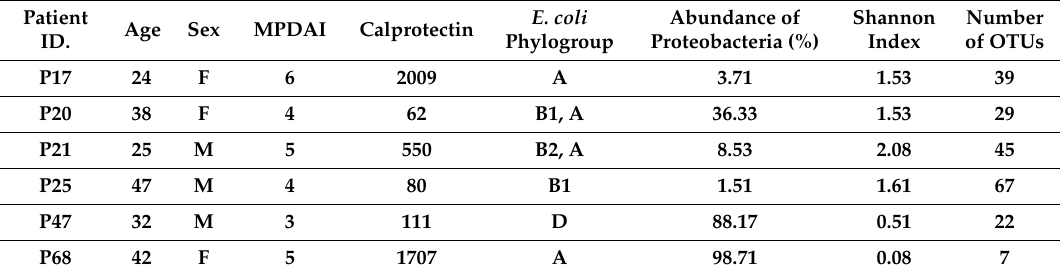
Table 1. Patient characteristics, modified pouchitis disease activity index (mPDAI), calprotectin, E. coli phylogroup, relative sequence abundance of Proteobacteria, Shannon index and number of operational taxonomical units (OTUs). Bold: active disease, mPDAI > 2 Patient